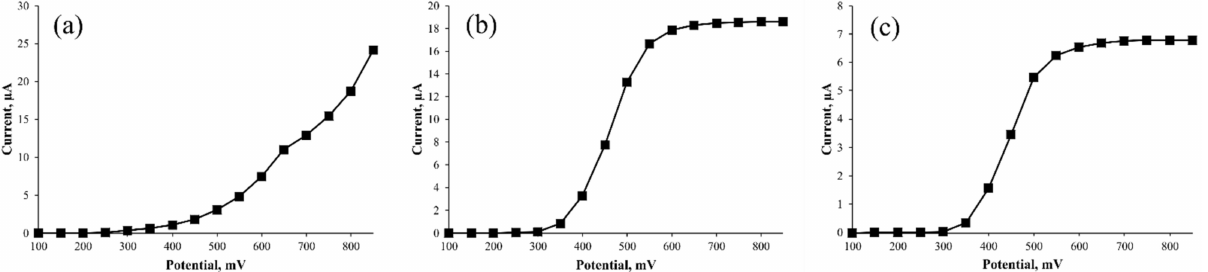
Figure 3. Corresponding hydrodynamic voltammograms of: ( a ) the first peak (unknown), ( b ) capsaicin, and ( c ) dihydrocapsaicin. Each point plotted in the graph corresponds to one area under the peak of one channel of the CoulArray